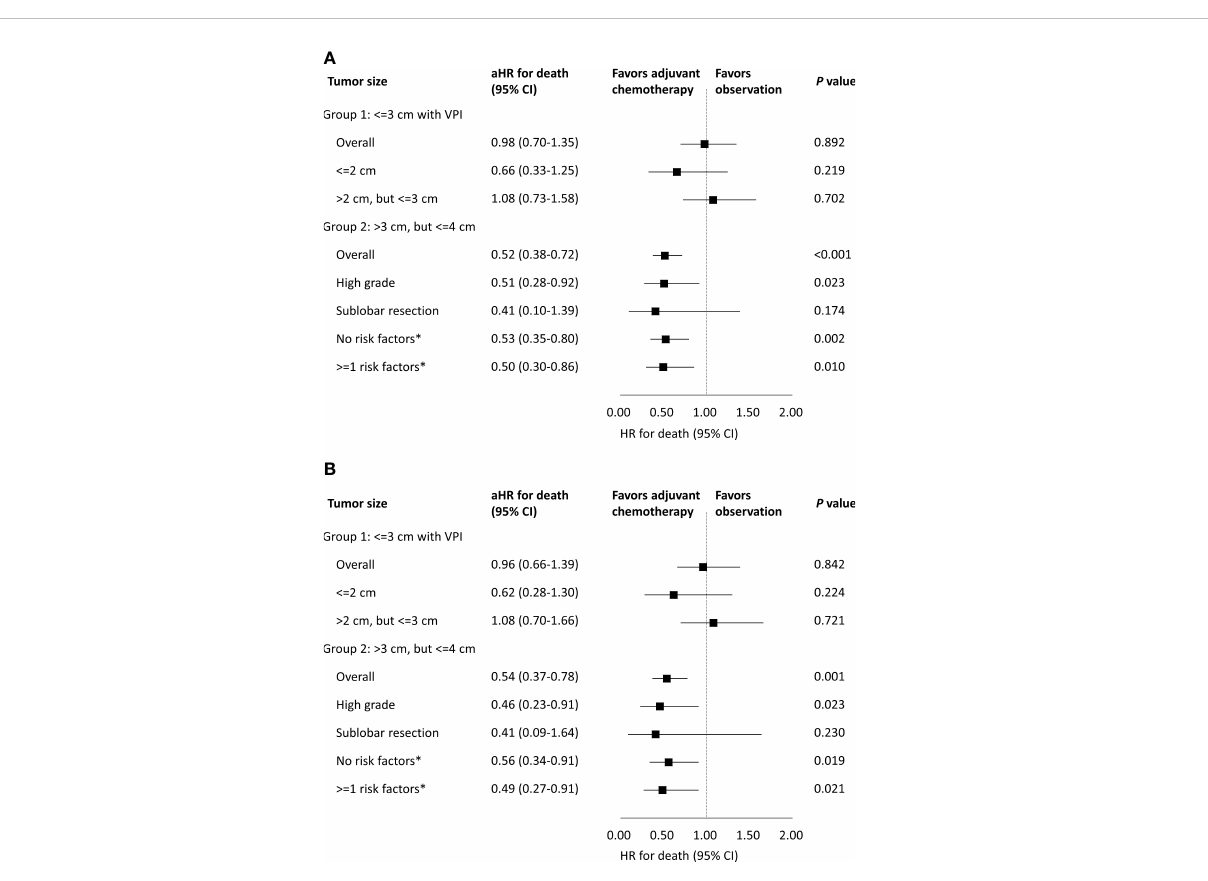
FIGURE 2 Association of (A) overall survival and (B) cancer-speci fi c survival with adjuvant chemotherapy strati fi ed by tumor size and risk factors. aHR, adjusted hazard ratio; CI, con fi dence interval; VPI, visceral pleura invasion. *The risk factor in group 2 refers to having either high-grade histologic fi ndings or receiving sublobar